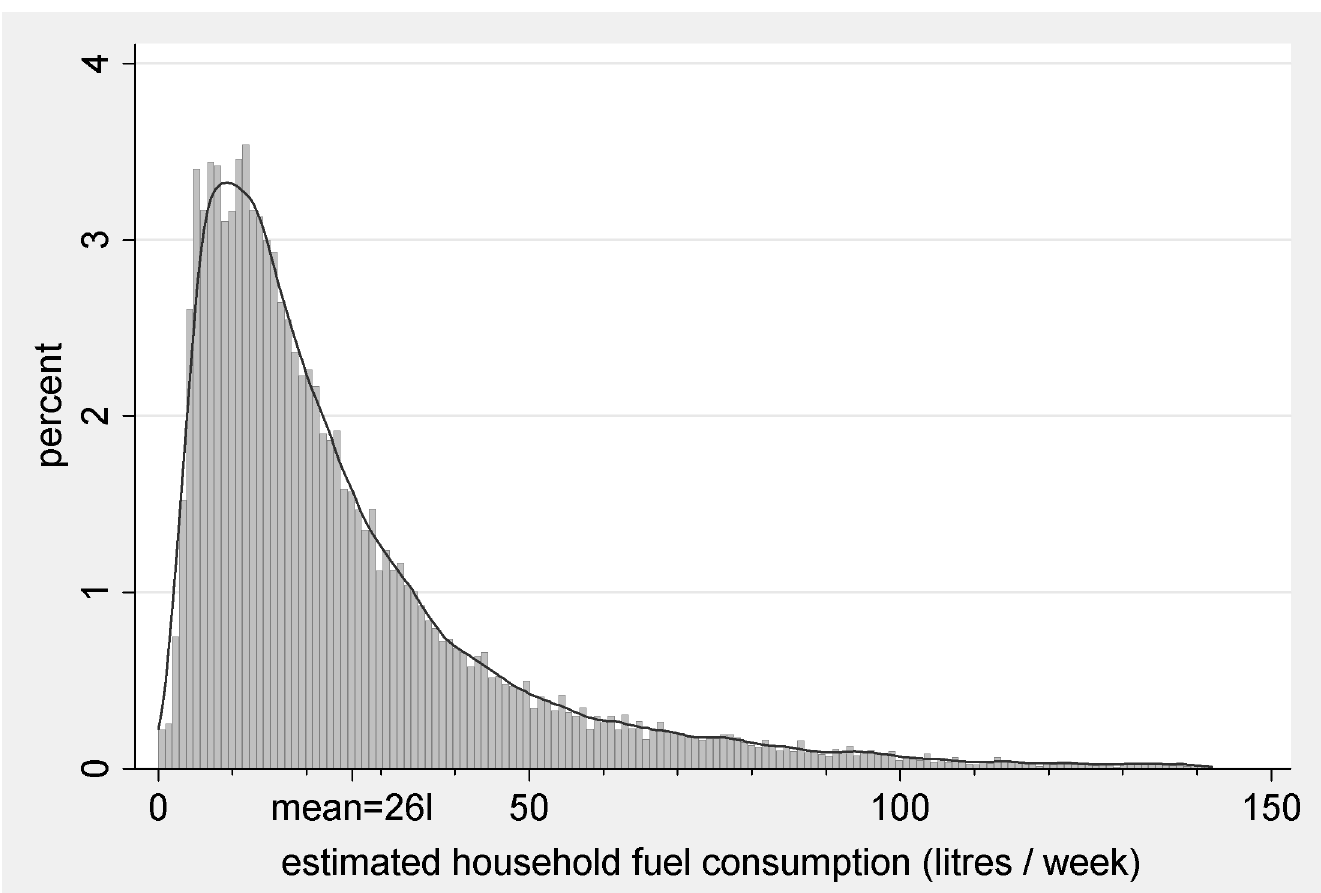
Fig 6. Preferredestimates of fuel consumption rates, derived from model 2. Notes. 1. Kernel density estimates (Epanechnikovkernel) overlaid. 2. Excludestop percentile.